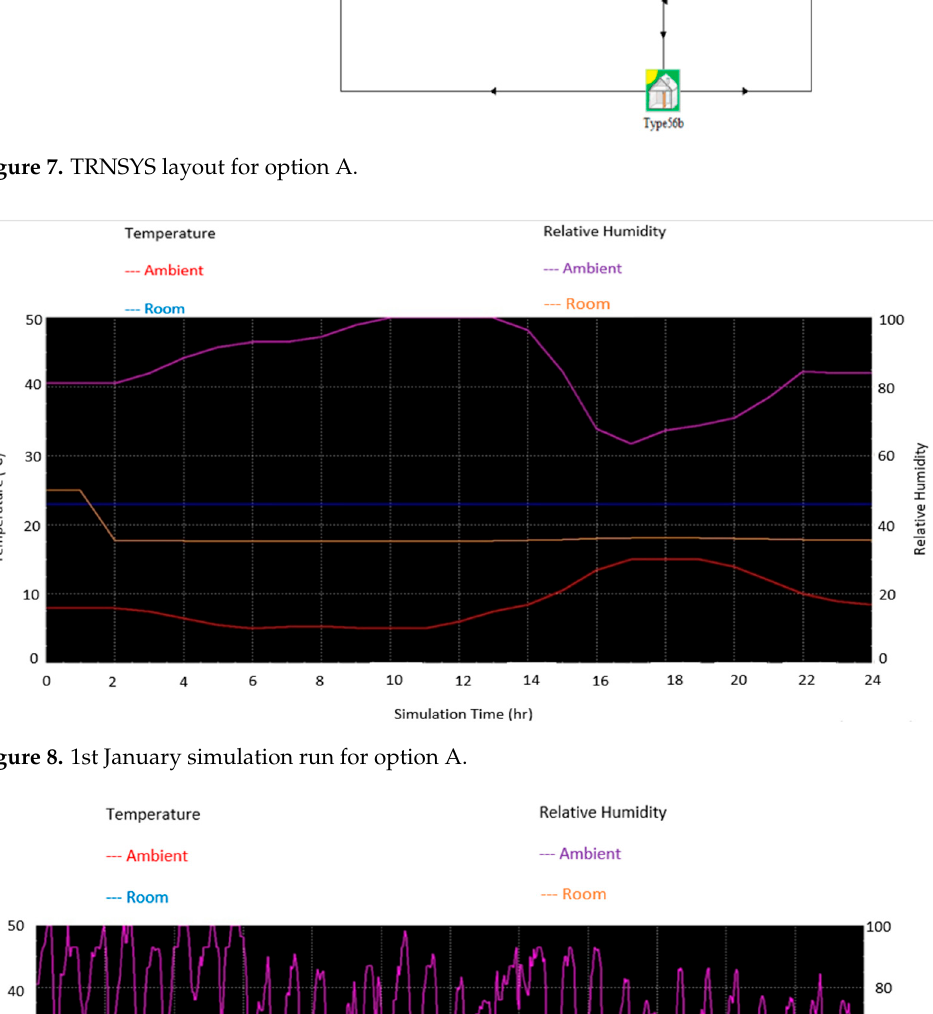
Figure 8. 1st January simulation run for option A.